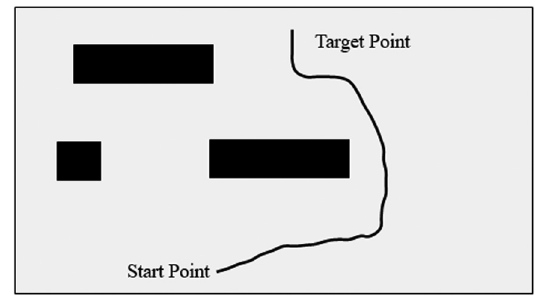
Figure 4: The planning path of breadth - fi rst search ( 2 ) .